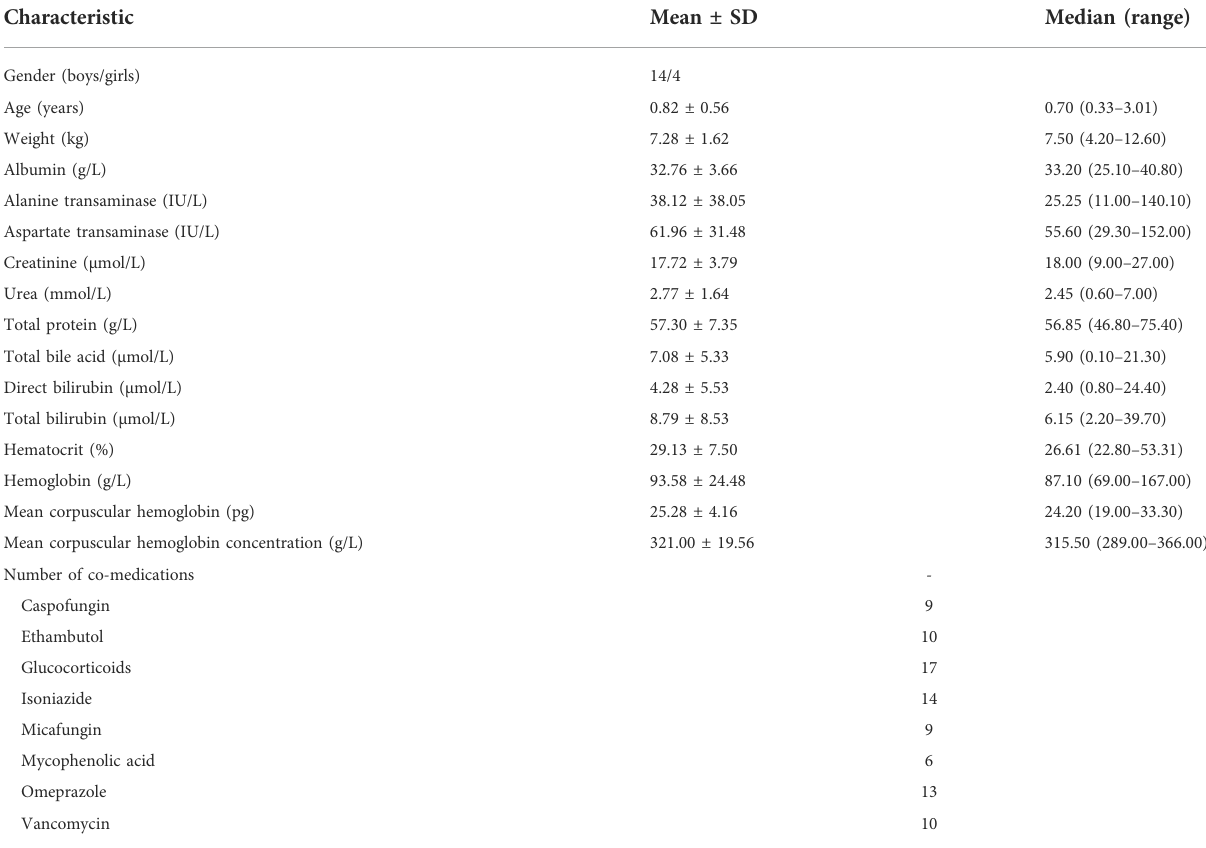
TABLE 1 Demographic data of patients and drug